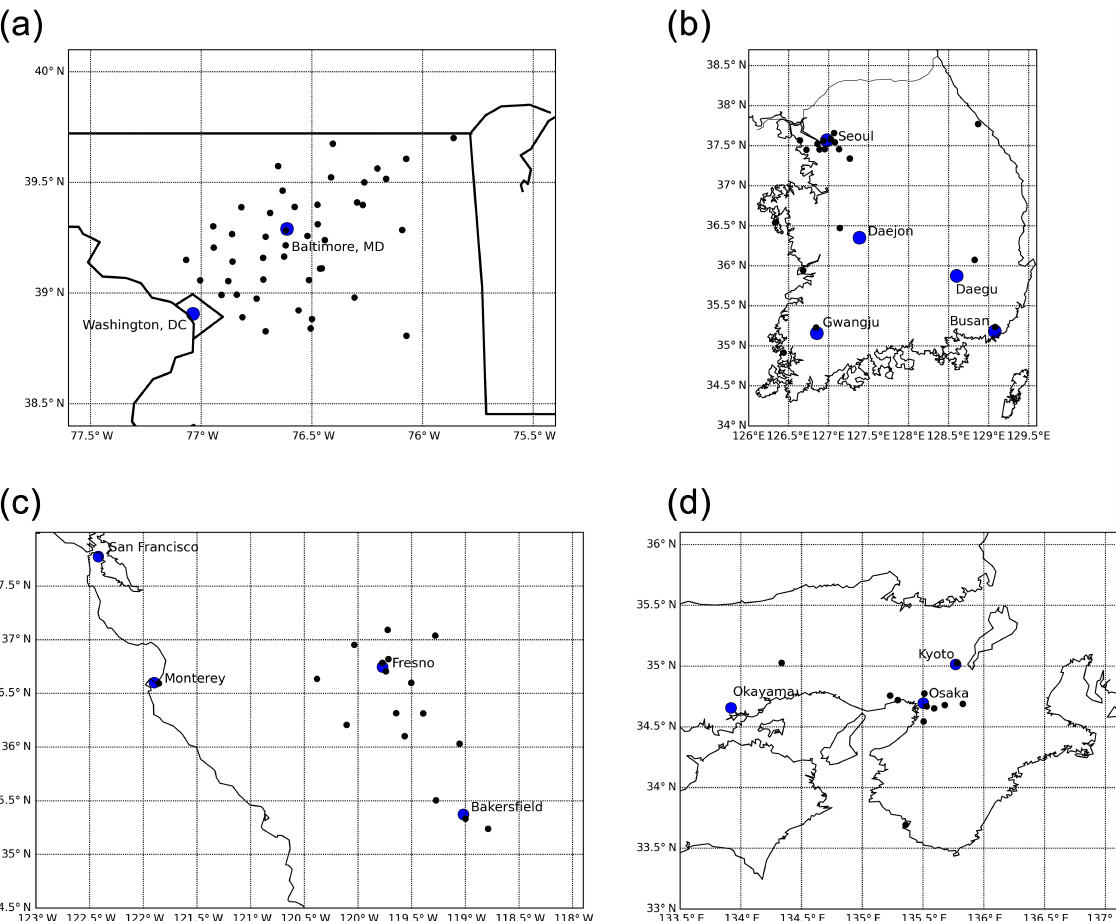
Figure 3. (a) Locations of the 45 sites deployed as part of the AERONET-DRAGON campaign in the Washington, DC–Baltimore metropoli- tan area; (b) locations of the 25 sites deployed in South Korea during DRAGON-Asia 2012; (c) locations of the 18 sites deployed in the San Joaquin Valley in California in late 2012 and early 2013; (d) locations of the 14 sites deployed in Japan during DRAGON-Asia